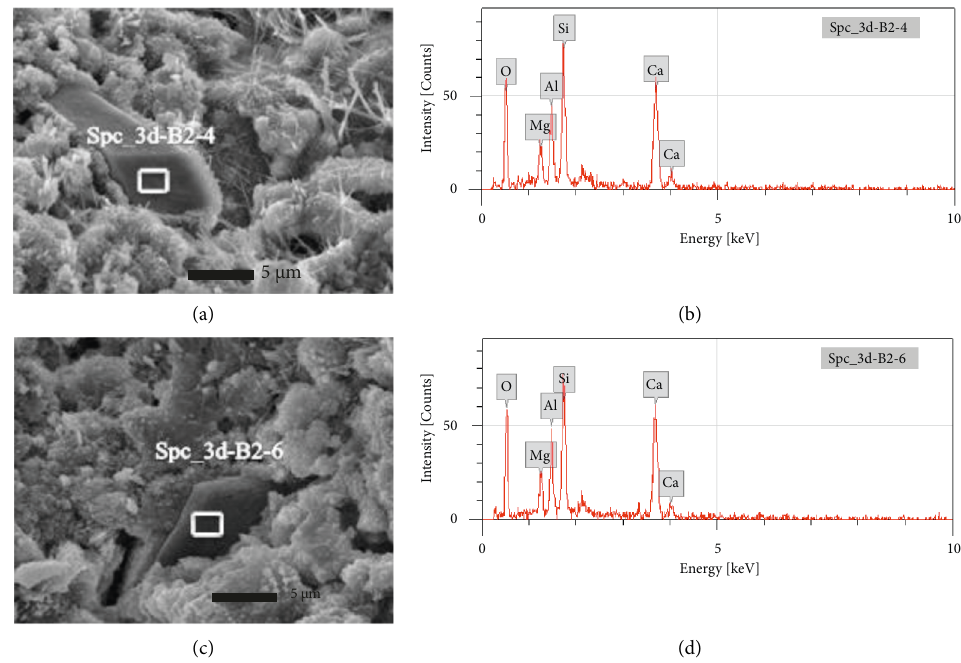
Figure 5: SSP-cement hydration microscopic morphology and energy spectrum analysis with the age of 3 d: (a) hydration microstructure with age of 3d, (b) energy spectrum analysis of area Spc_3d_B2-4, (c) hydration microstructure with age of 3d, and (d) energy spectrum analysis of area